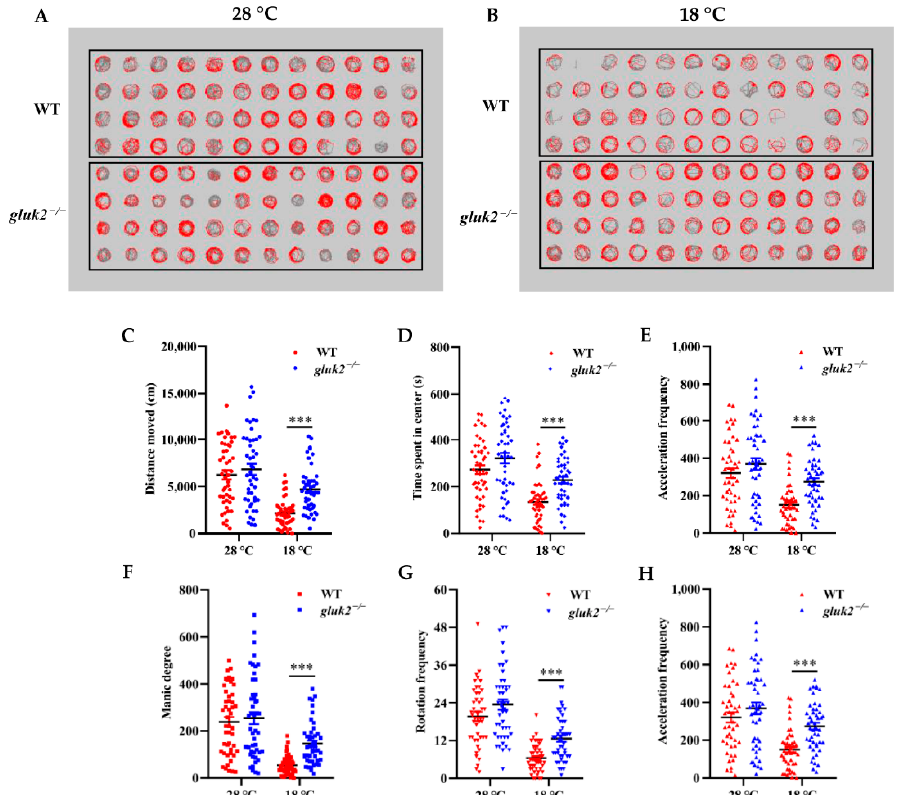
Figure 3. Effects of low temperature on the 7 dpf wild-type and gluk2 − / − zebrafish locomotor activities. ( A ) Wild-type and gluk2 − / − zebrafish in a 96-well plate during tracking at 28 °C. ( B ) Wild-type and gluk2 − / − zebrafish in a 96-well plate during tracking at 18 °C. ( C ) Distance moved by the wild-type and gluk2 − / − zebrafish larvae at 28 °C and 18 °C. ( D ) Time spent in center by the wild-type and gluk2 − / − zebrafish larvae at 28 °C and 18 °C. ( E ) Acceleration frequency by the wild-type and gluk2 − / − zebrafish larvae at 28 °C and 18 °C. ( F ) Manic degree by the wild-type and gluk2 − / − zebrafish larvae at 28 °C and 18 °C. ( G ) Rotation frequency by the wild-type and gluk2 − / − zebrafish larvae at 28 °C and 18 °C. ( H ) Active frequency by the wild-type and gluk2 − / − zebrafish larvae at 28 °C and 18 °C. Values plotted are means ± SEM, ** p < 0.01, *** p < 0.001, compared with control.